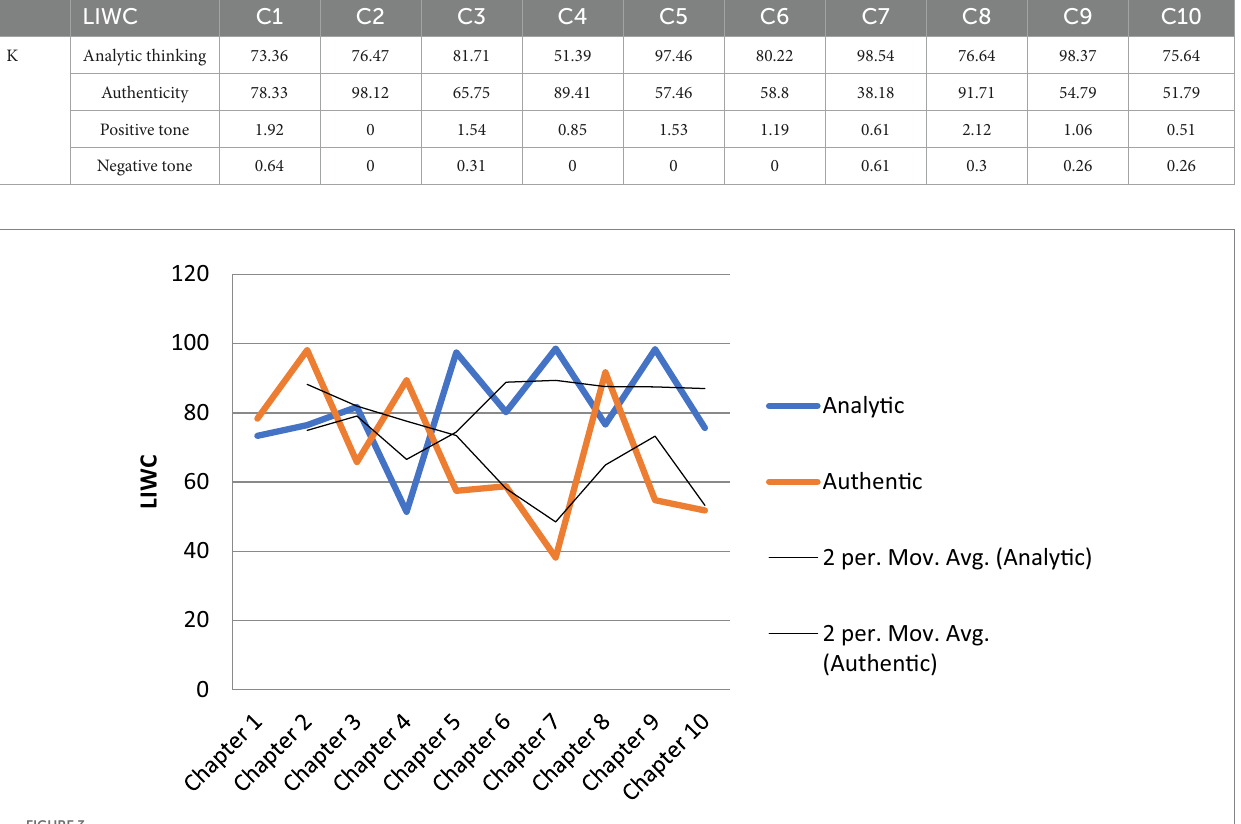
FIGURE 3 K’s analytic thinking and authenticity across 10 chapters.